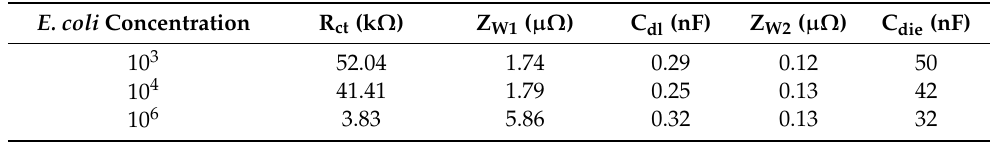
Table 2. Simulated data of the component in the equivalent circuit for the E. coli sample at different concentrations.